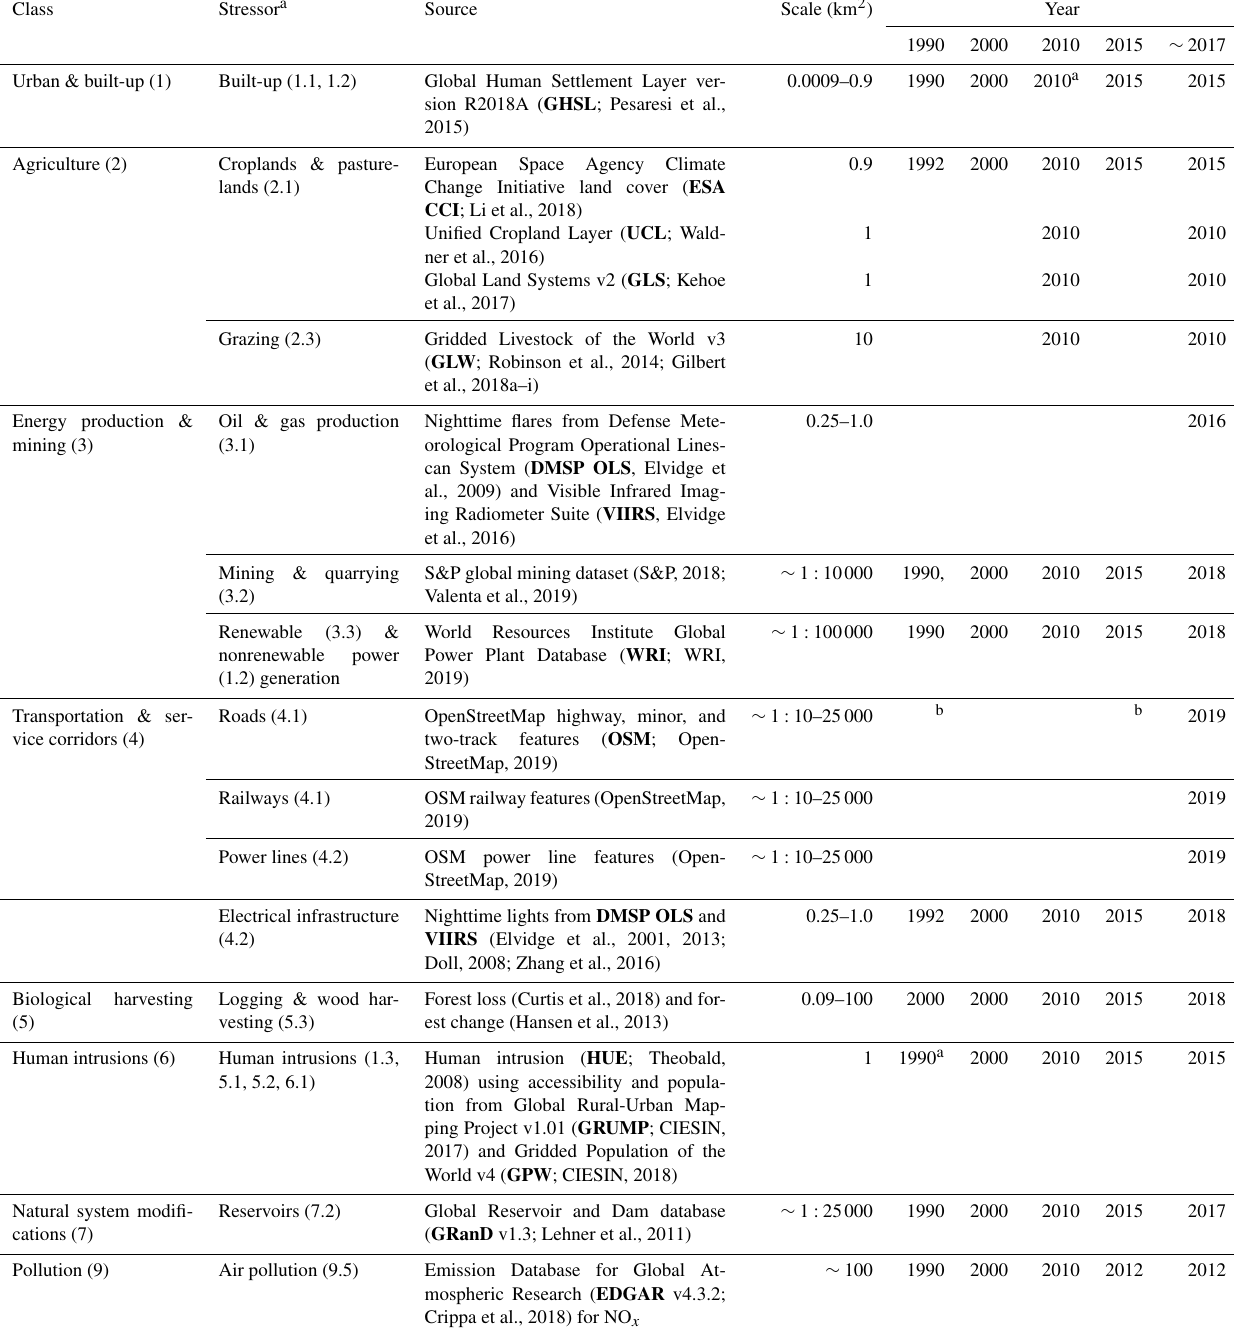
Table 1. Overview of stressors, datasets, spatial resolution, and years data were available and used in the maps of human modification. Stressor classification levels in parentheses correspond to those within the Direct Threats Classification v2 (Salafsky et al., 2008). Acronyms of source data are in bold in the “Source” column for reference throughout the paper. For each stressor, the years 1990–2015 are used for change analysis, and ∼ 2017 is a compilation of all stressors that represents “current” conditions with the median year of